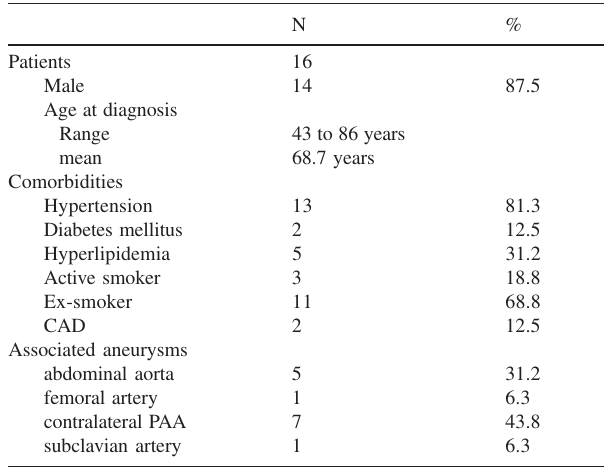
Table 1 - Patient characteristics and associated aneurysms in this study